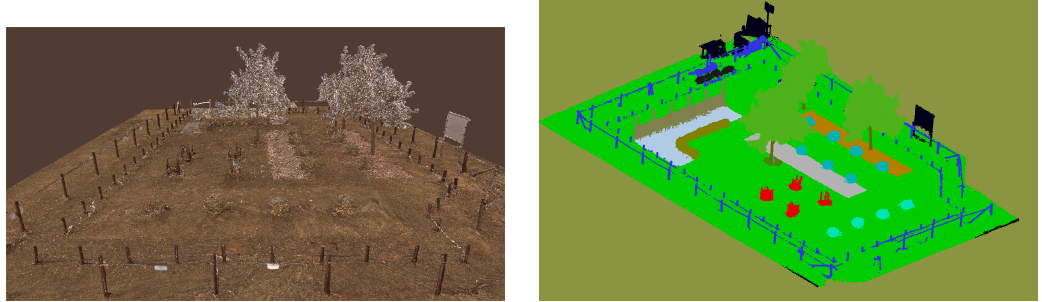
Figure A4. The captured point cloud of the garden (left) is labelled in the 3D editor to produce a semantic point cloud with colour-coded class labels